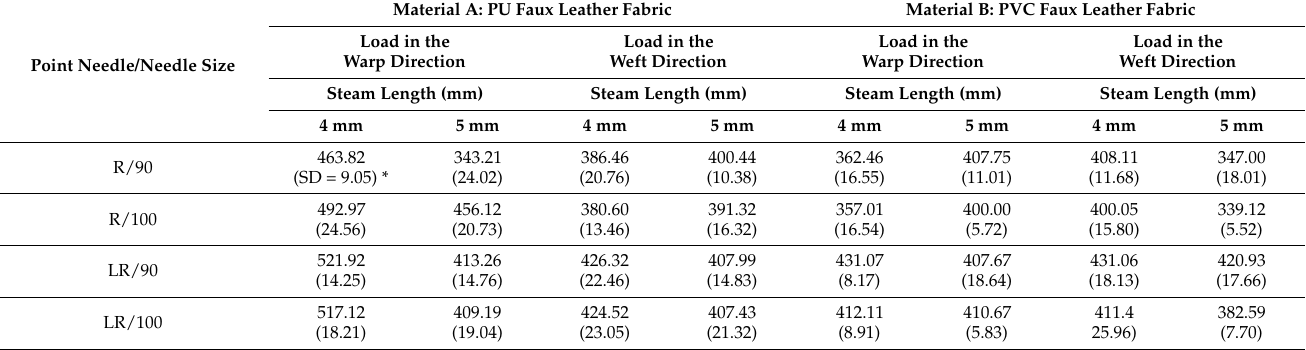
Table 1. Average values of unseamed fabric strength F FLmax (N). Table 2. Average values of seamed fabric strength F Smax (N). * The standard deviation (SD) is given in